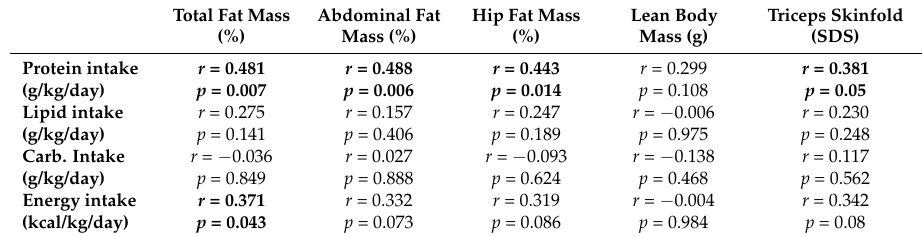
Table 3. Relationship between early macronutrient intake and parameters of body composition in former ELBW subjects at 9.5 years. of age as indicated by Spearman’s correlation coefficients ( n = 30). Total Fat Mass Abdominal Fat (%) Mass